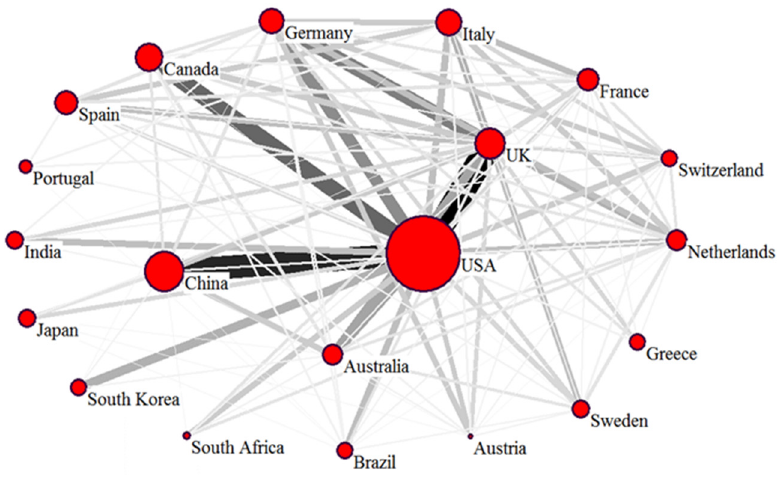
Figure 3. International collaboration according to social network analysis .